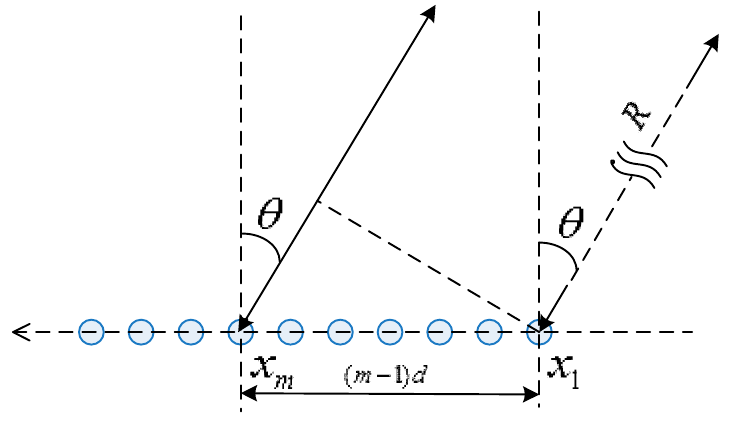
Figure 1. Echo delay diagram.